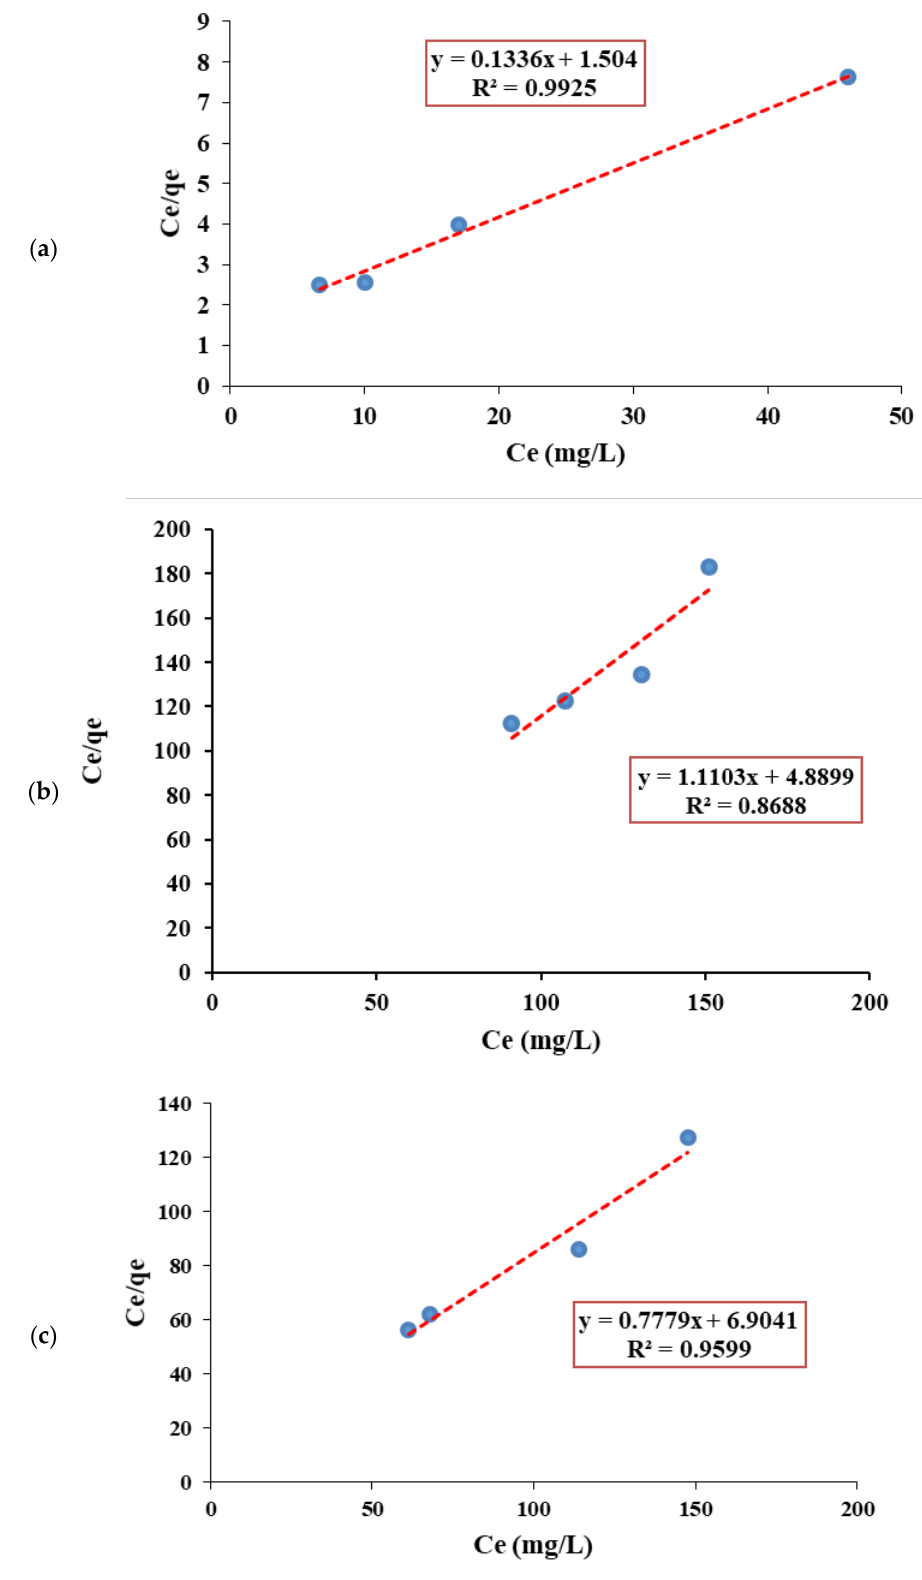
Figure 15. Linear form of Langmuir isotherm model for the adsorption of calcium ions by ( a ) zeolite, ( b ) activated carbon, and ( c ) activated alumina.